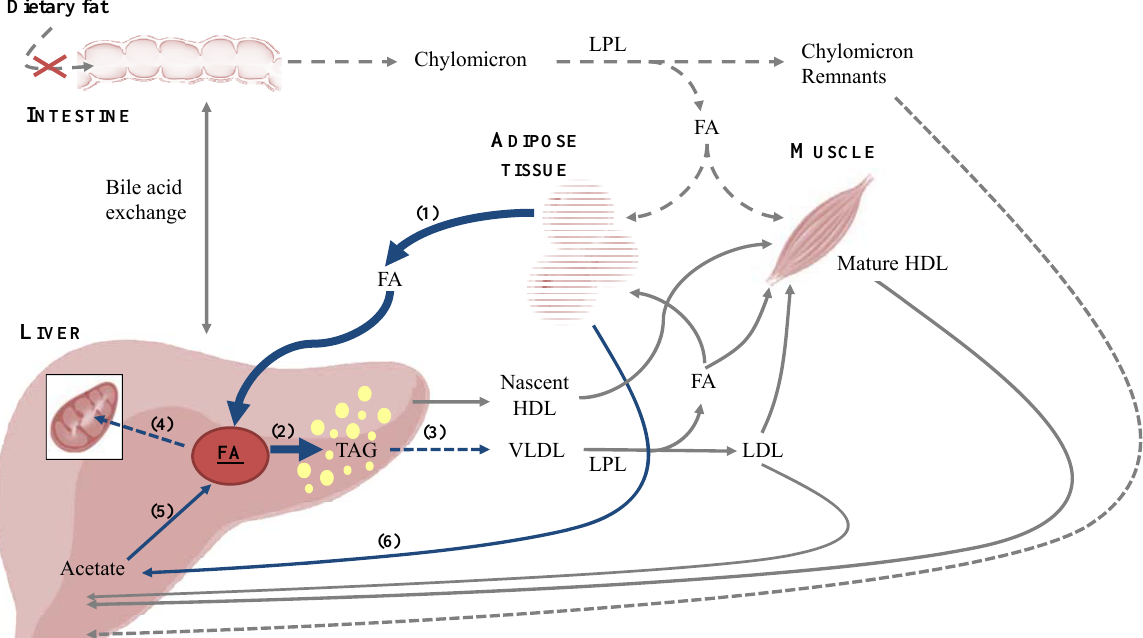
Figure 3. Lipid metabolism in fasting cats. Fasting in cats promotes lipolysis in adipose tissue and transportation of free fatty acids to the liver ( 1 ). In the liver, fatty acids are reconstituted in triacylglycerol (TAG) ( 2 ), which are secreted from the liver in very-low-density lipoproteins ( 3 ) or are transported over the mitochondrial membrane by L -carnitine to enter β -oxidation ( 4 ). The hepatic load of fatty acids is also increased by de novo synthesis of fatty acids, most probably by use of acetate a carbon source ( 5 ), resulting from ketogenesis ( 6 ). An imbalance between these different aspects of the feline lipid metabolism leads to accumulation of lipids in the liver, represented as yellow fat droplets. HDL: high-density lipoproteins; FA: fatty acids; LDL: low-density lipoproteins; LPL: lipoprotein lipase; NEFA: non-esterified fatty acids; TAG: triacylglycerols; VLDL: very-low-density